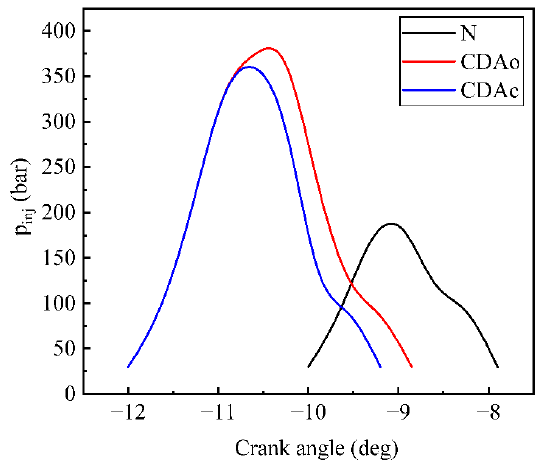
Figure 6. Injection profile under the normal operation and injection profiles in the active cylinder under two CDA modes at a speed of 450 rpm and a load of 1000 N ∙ m.